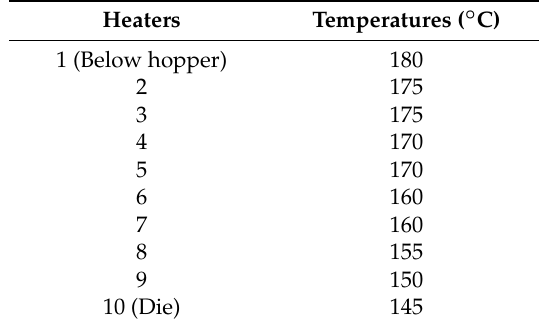
Table 1. Barrel temperatures of poly (3-hydroxybutyrate-co-3-hydroxyvalerate) (PHBV)/natural rubber (NR) reactive extrusion.